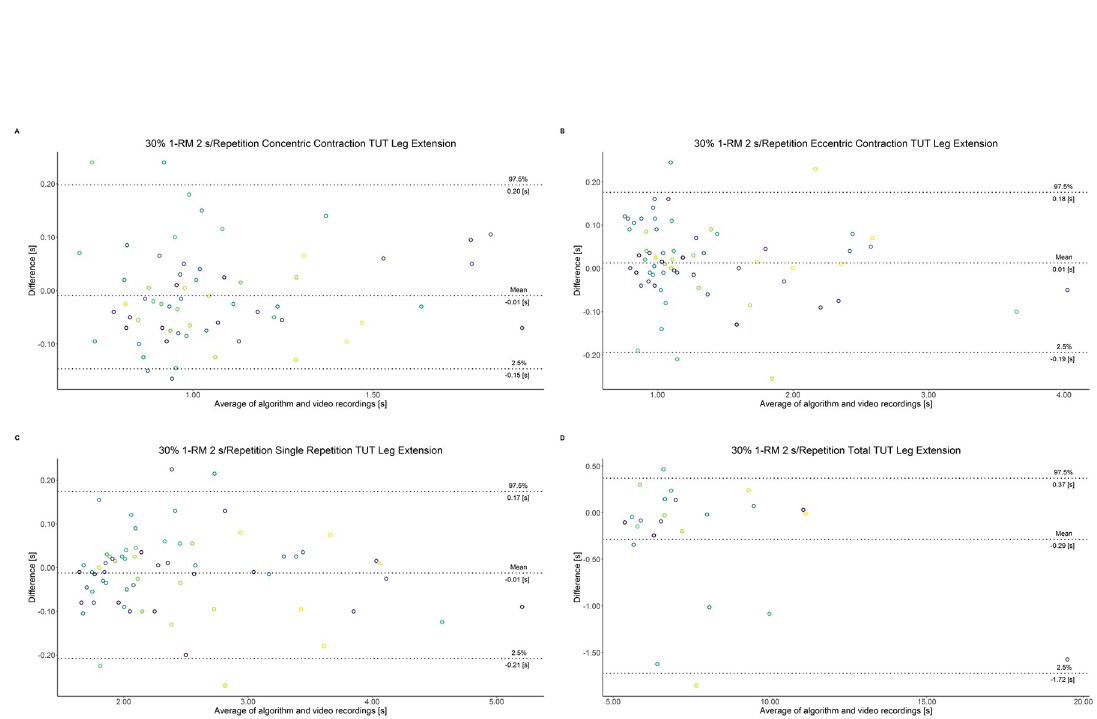
Fig 4. Bland-Altman plots of agreement between algorithmically accelerometer derived and video recordings derived contraction- specific phases of the leg extension machine at 30% 1-RM with a velocity of 2 s per repetition. A: Concentric contraction phase. B: Eccentric contraction phase. C: Single repetition. D: Total